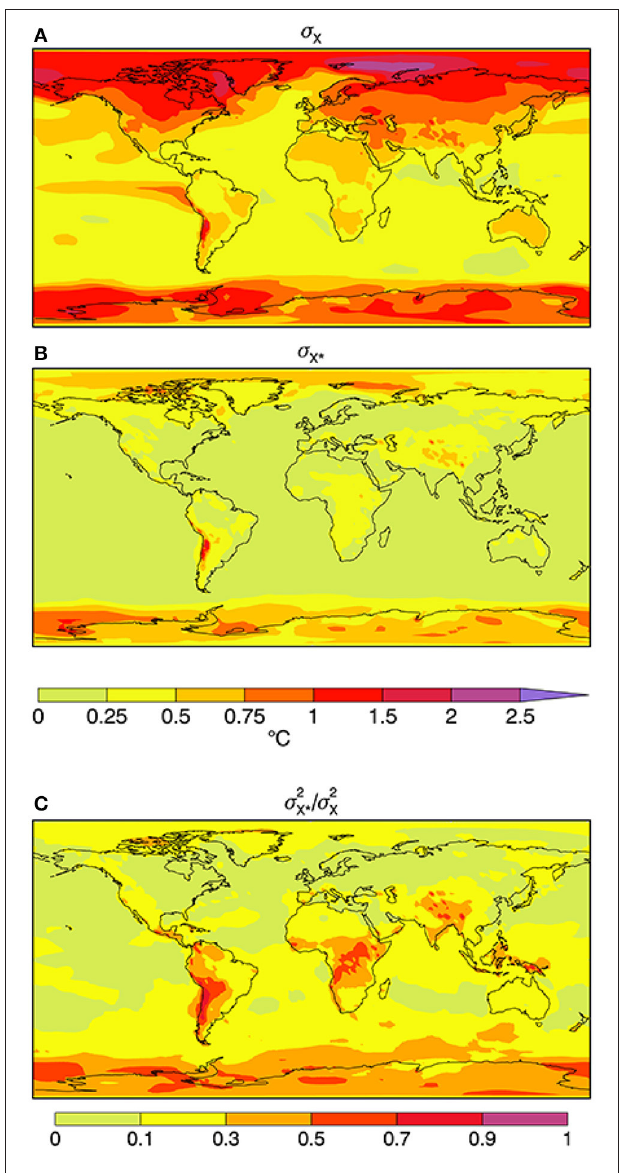
FIGURE 3 | Standard deviations (A) σ X and (B) σ X temperature under time and ensemble averaging where